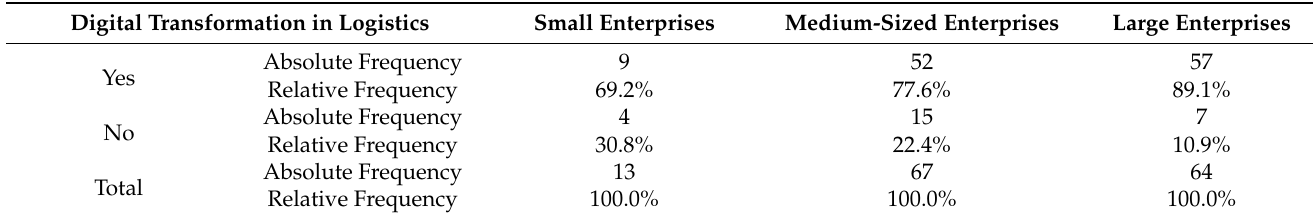
Table 3. Data file structure by digital transformation in